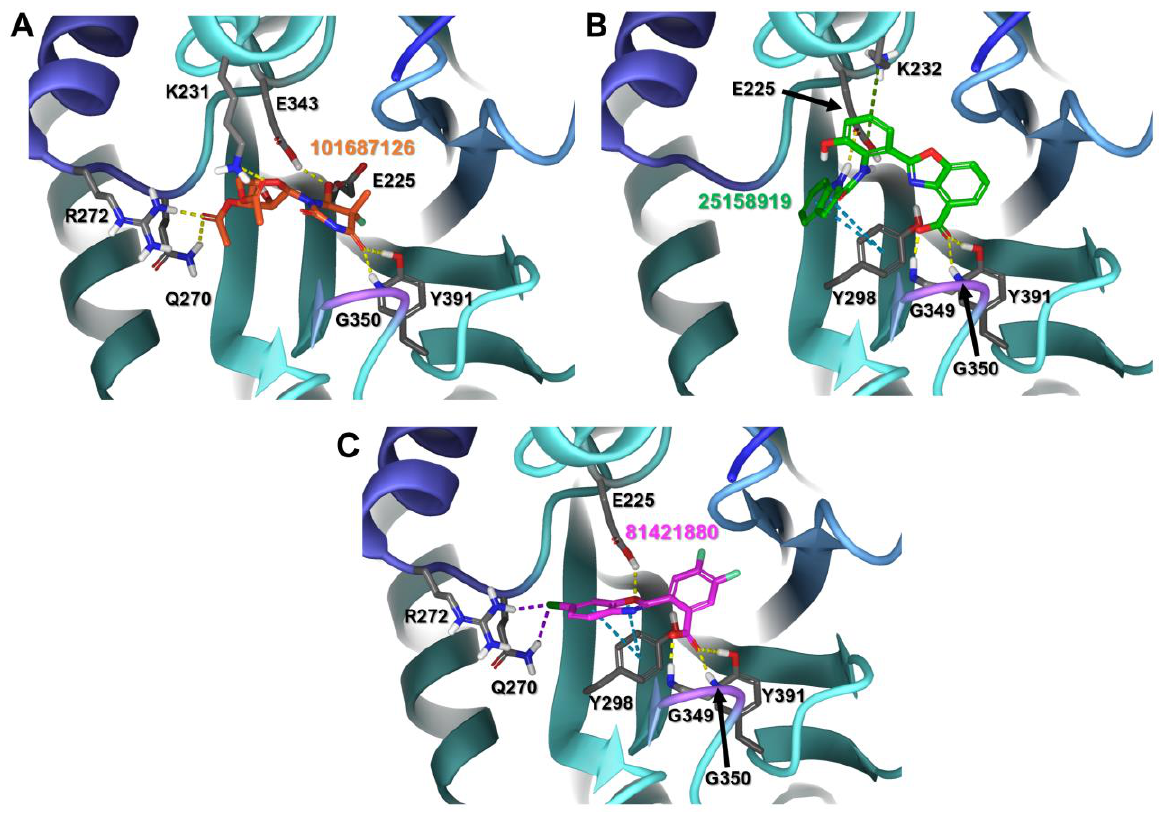
Figure 4. HPSE in complex with the best potential inhibitors from each library screening of each library: ( A ) 101,687,126 (orange); ( B ) 25,158,919 (green); ( C ) 81,421,830 (pink). Interactions are shown in dashed lines: H-bond (yellow); halogen bond (purple); pi-pi stacking (blue); pi-cation (green). All the potential HPSE inhibitors are shown in stick